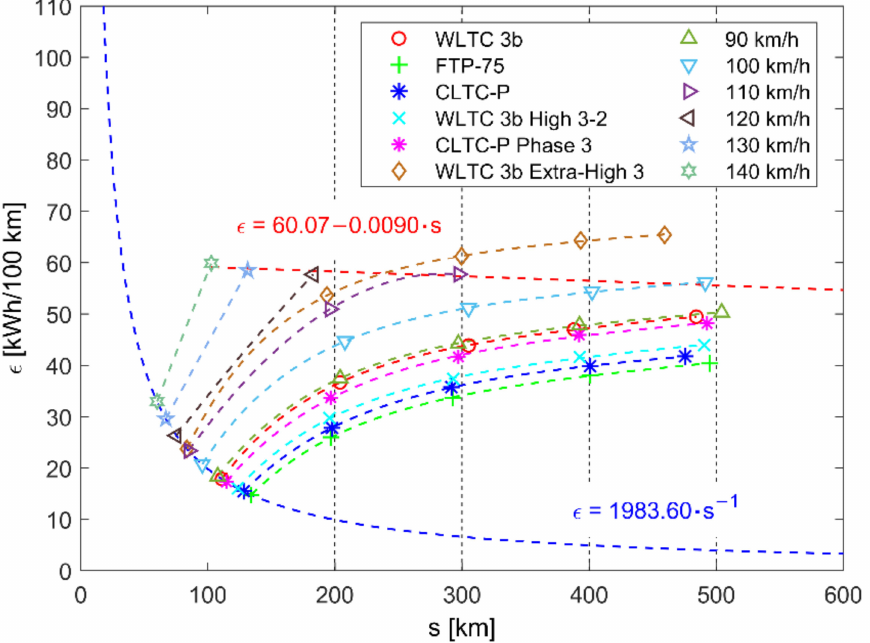
Figure A15. Specific energy consumption results for BEV mode and EREV drive (four EREV range targets indicated with dashed vertical lines) in various drive cycle conditions. Vehicle mass is equal to 1800